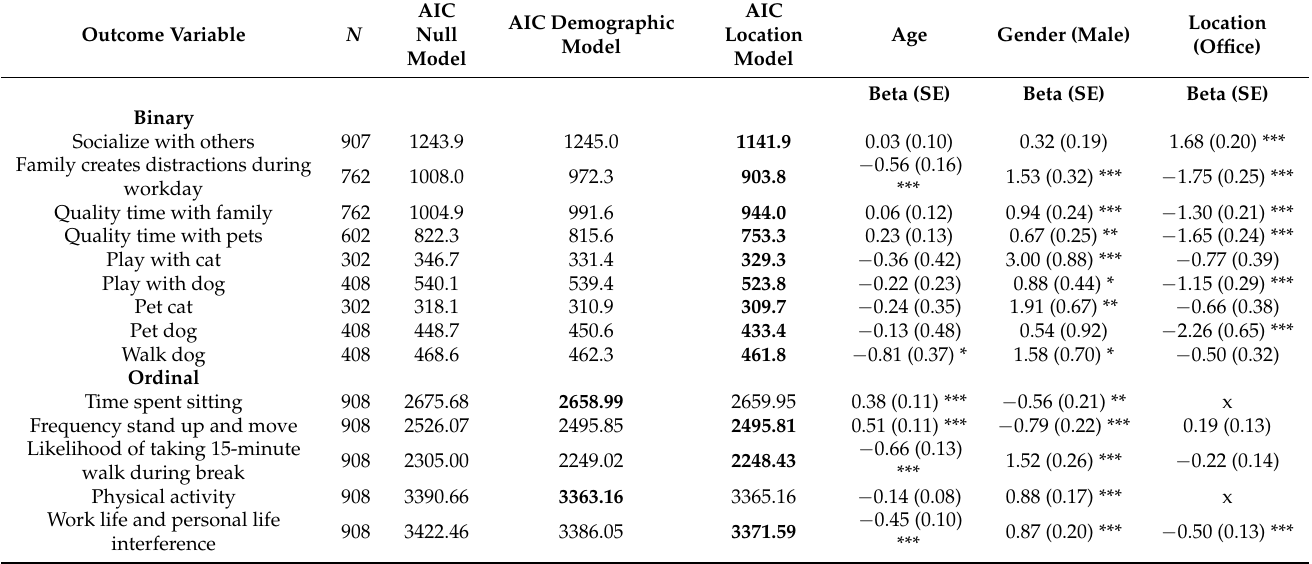
Table 3. Regressions on outcome variables in relation to age, gender, and workplace location. Betas and standard errors are only included for covariates that were part of the final model. Bolded AIC values indicate which model was best. Note that N represents the number of data points analyzed; participant identification number was treated as a random effect in this model to account for each participant providing information about working from home and from the